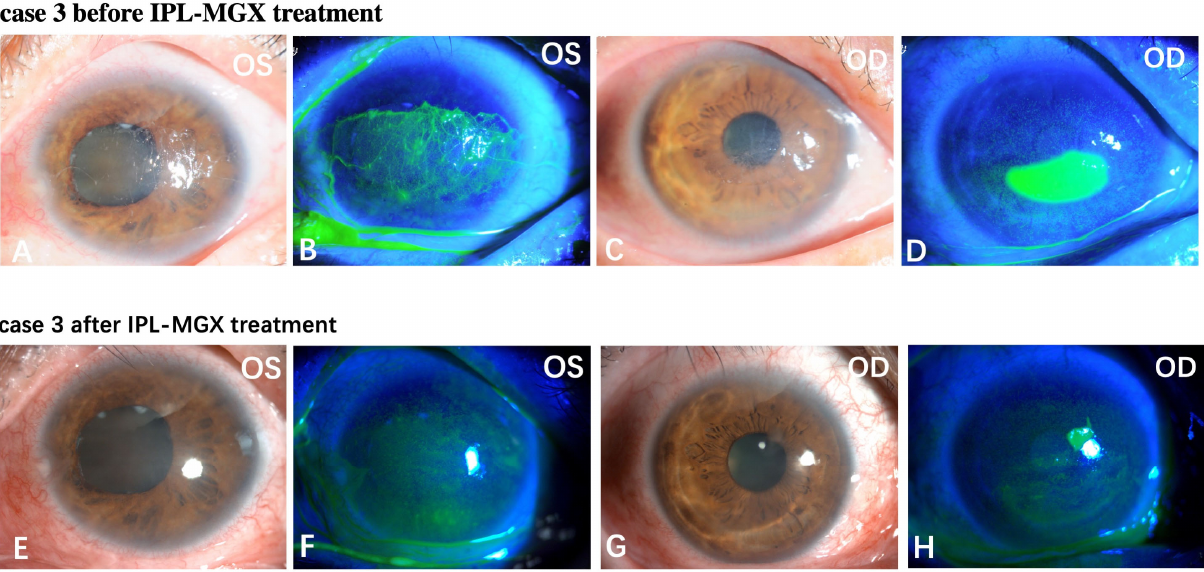
Figure 5. Case 3 in the IPL-MGX group exhibited considerable improvement in the ocular surface condition from baseline to the last follow ‐ up assessment. Images of the ocular surface and corneal fluorescein staining of both eyes at baseline ( A – D ) and during the last follow ‐ up visit. ( E – H ).